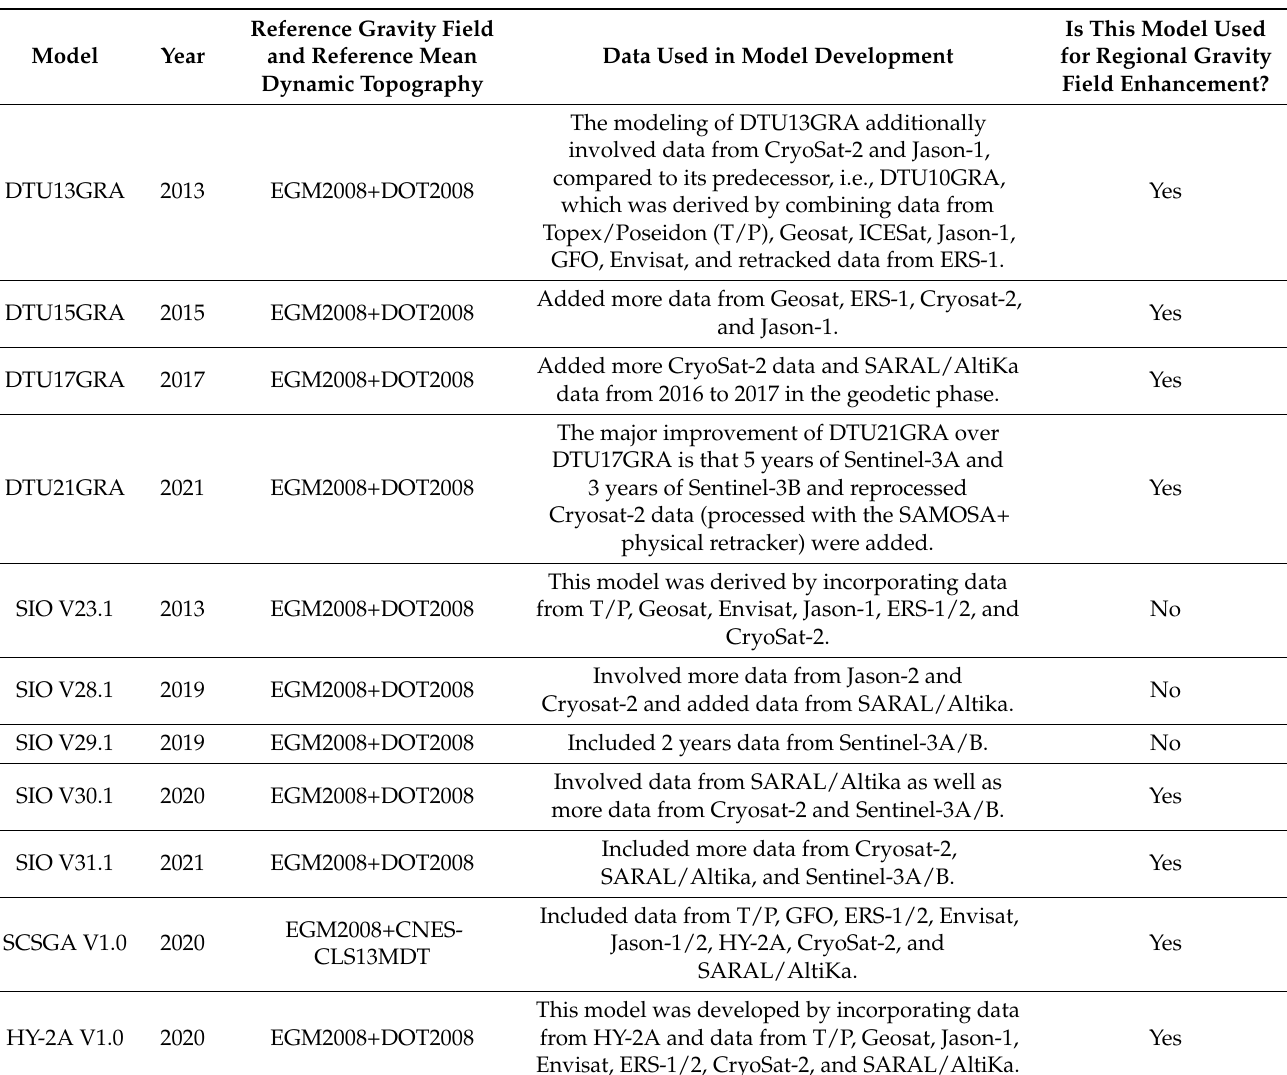
Table 1. Description of the selected satellite altimeter-derived marine gravity field